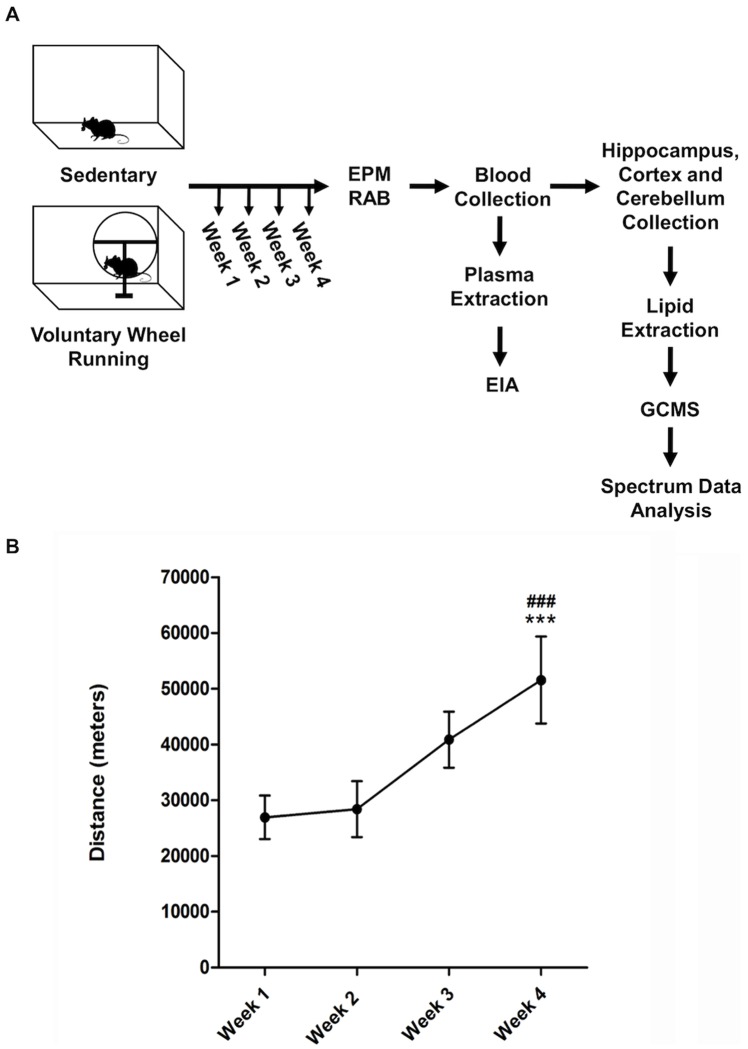
Experimental Design and Distance Run As a Measure of Voluntary Exercise.
A. Schematic representation of the voluntary wheel running protocol design, including additional behavioral and molecular procedures. After four weeks of running wheel training, mice were evaluated with the EPM/RAB measures. Next, blood was collected, brains were extracted, and brain regions dissected. Later, plasma samples were obtained from blood to examine corticosterone levels with an Enzyme Immunoassay (EIA). FA were extracted from the dissected brain regions and non-targeted neurolipidomic analysis was performed using GC/MS. B. Distance in meters ran by the mice in the Running group (N = 18). One-Way repeated measures ANOVA identified a significant increase in the distance ran throughout the weeks of training (F (3, 71)  = 7.489, ***P<0.0005). Bonferroni post-testing showed a specific significant increase in running distance when comparing week 1 versus week 4 and week 2 versus week 4 (***P<0.001 each comparison). Data are expressed as the mean ± SEM.